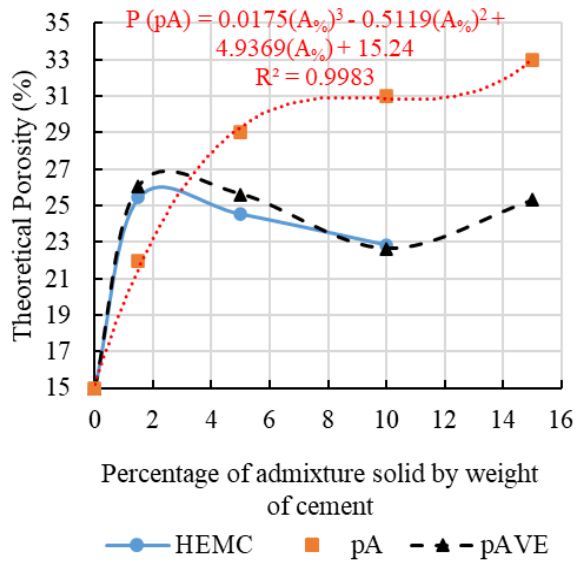
Figure 9. Theoretical Porosity